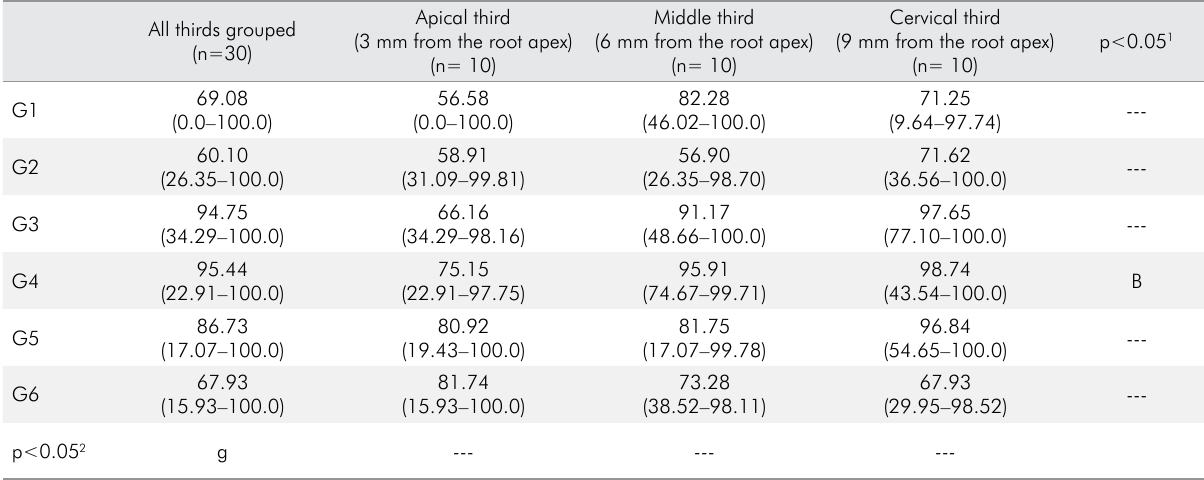
Table 3. Cement penetration assessed by penetration perimeter ratio (median, minimum, maximum, and comparisons) All thirds grouped